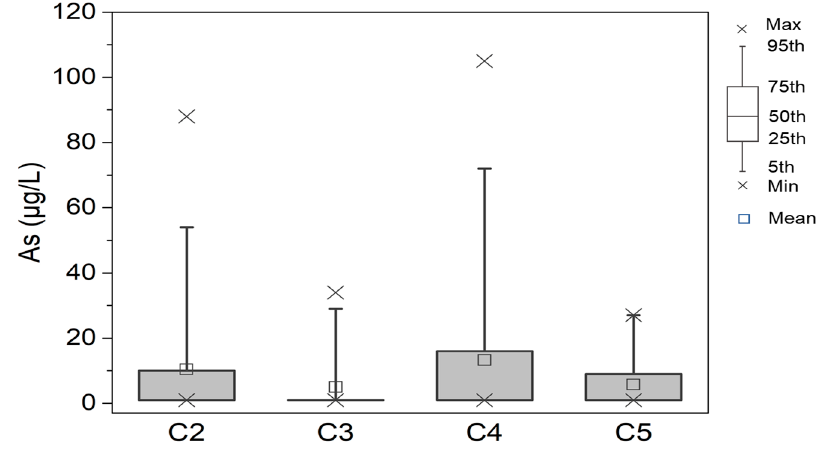
Figure 4. Box plot of the As concentrations in the four zones.